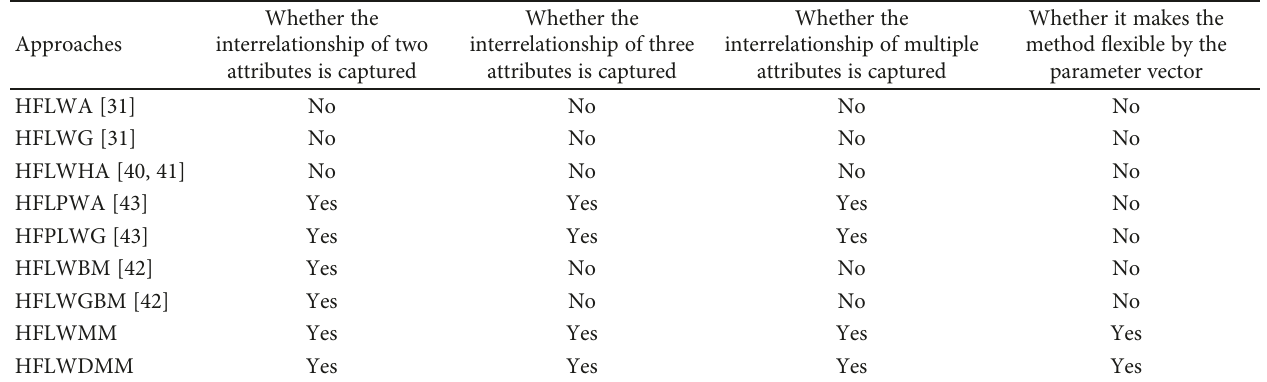
Table 4: Comparison of di ff erent approaches and aggregation